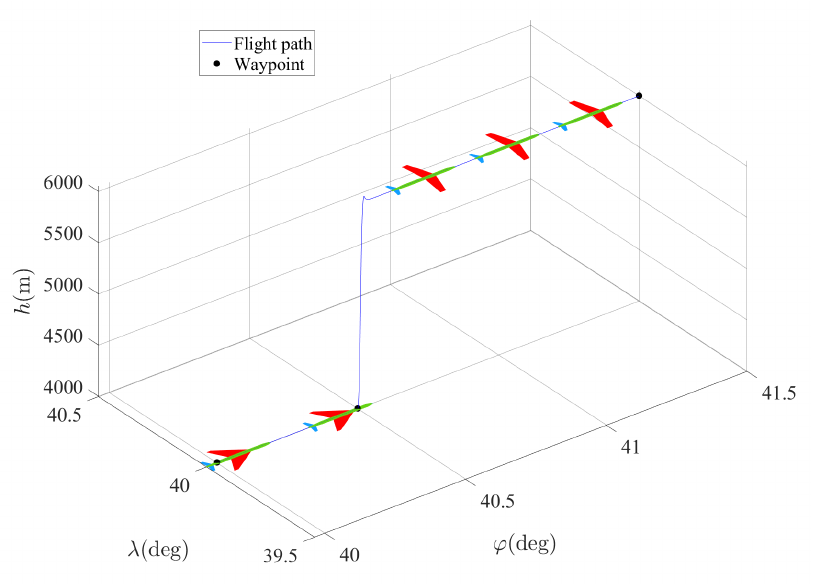
Figure 22. Flight path of the morphing aircraft with the proposed morphing strategy in Section